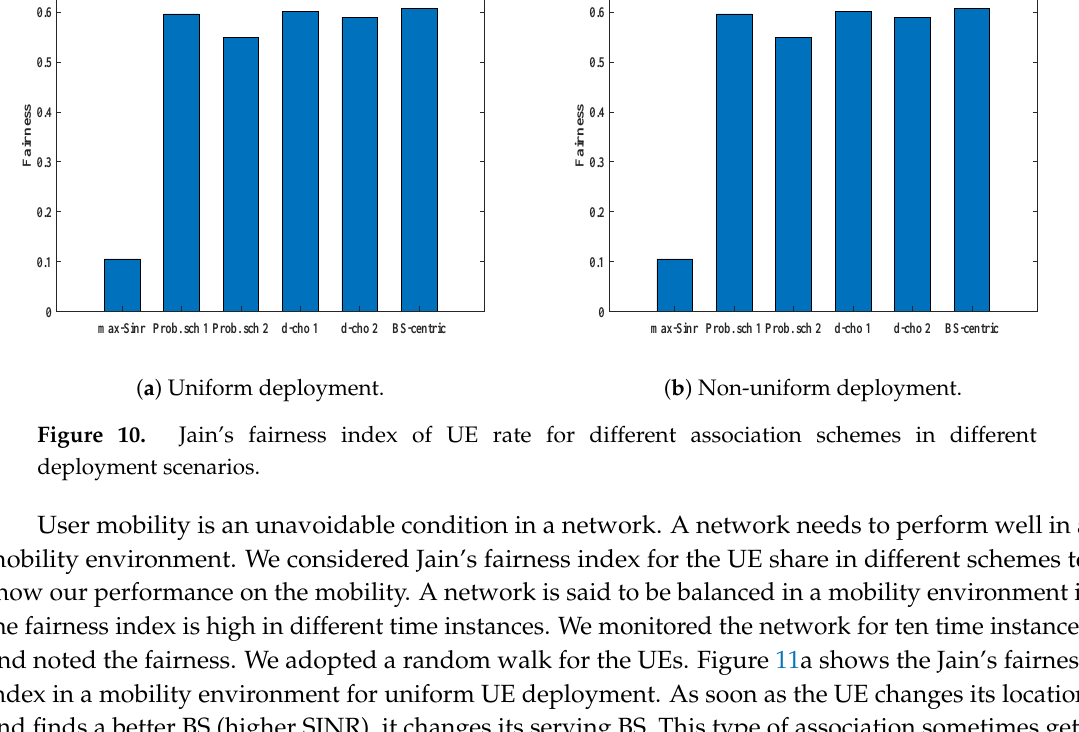
Figure 10. Jain’s fairness index of UE rate for different association schemes in different deployment scenarios.